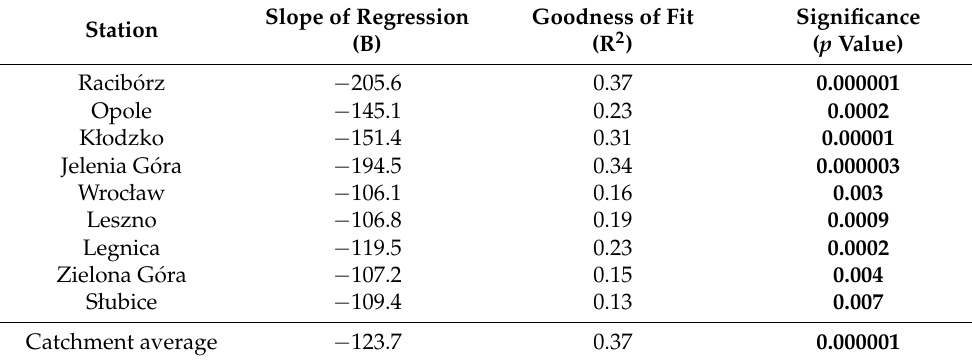
Table 2. Results from linear regression analysis for relationships between annual precipitation totals recorded at 9 stations from the upper and middle parts of the Odra River catchment as well as catchment-average annual precipitation, and annual values of the NAO index. p -values < 0.05 are indicated in bold. Slope of Regression